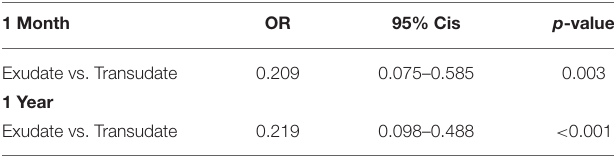
TABLE 6 | Transudates vs. exudates (excluding MPEs) on mortality.